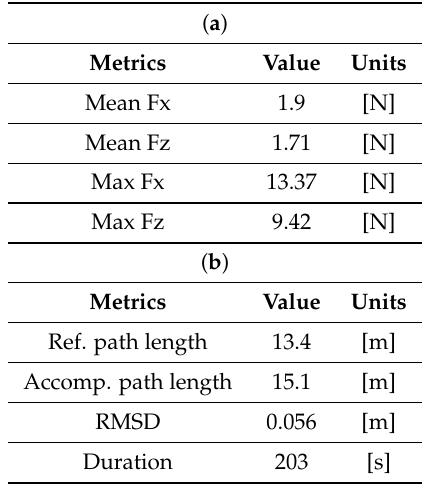
Table 3. Key figures of the path planning experiment performed in the water tank. ( a ) Mean and max force reference commands obtained by FL controller. ( b ) Length of the reference path and the accomplished path, RMSD, and the duration of the